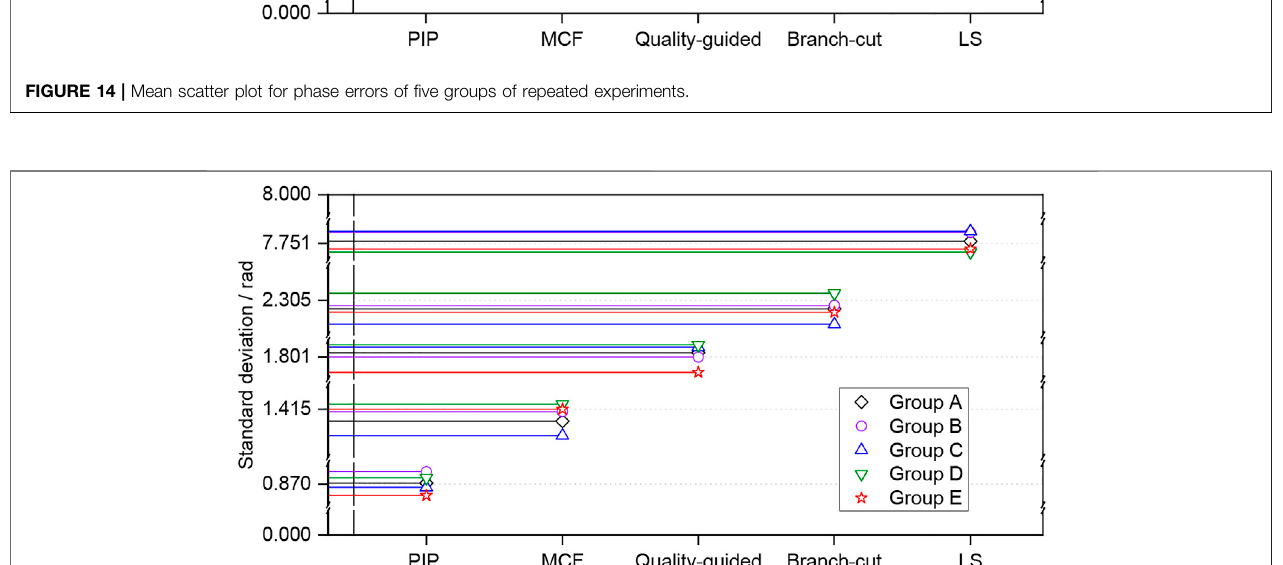
FIGURE 15 | Standard deviation scatter plot for phase errors of fi ve groups of repeated experiments.